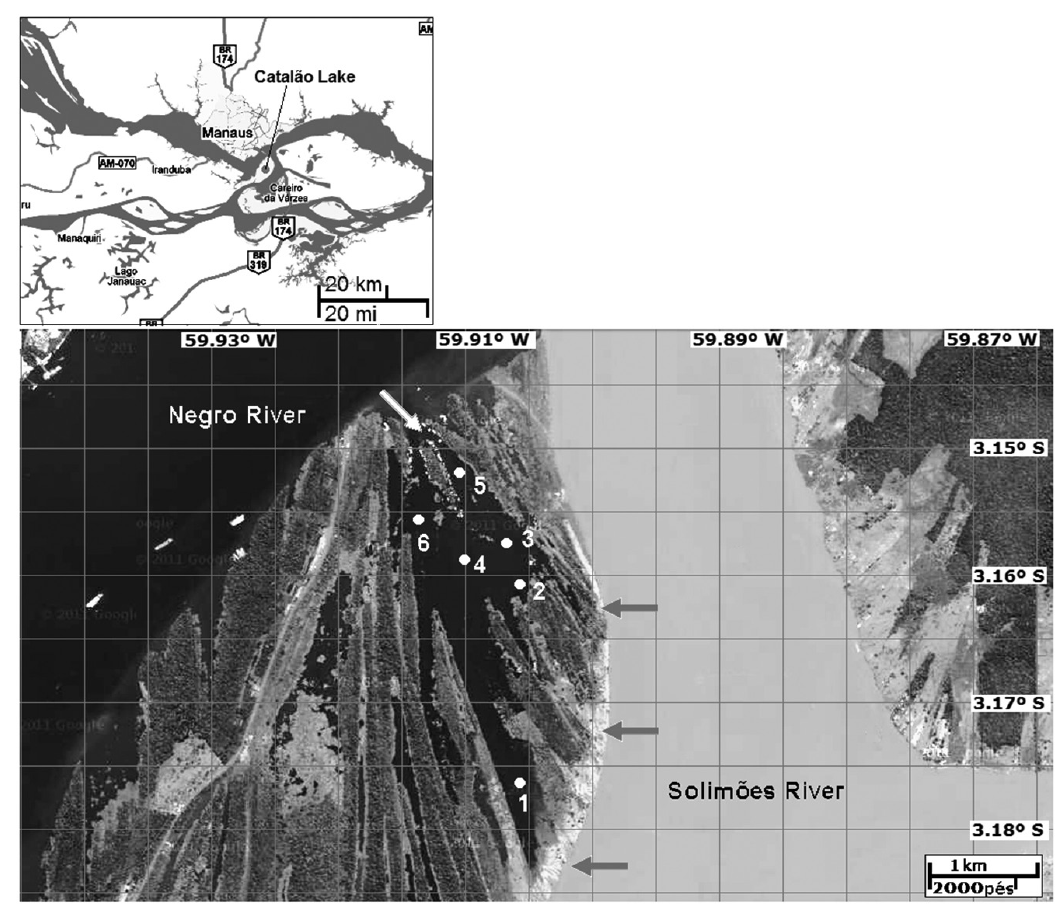
Figure 1. Location of the Catalão Lake basin, near the meeting of the waters of the Solimões and Negro rivers, with the sampling stations, indicating the major pathways of water flow and sediment to the